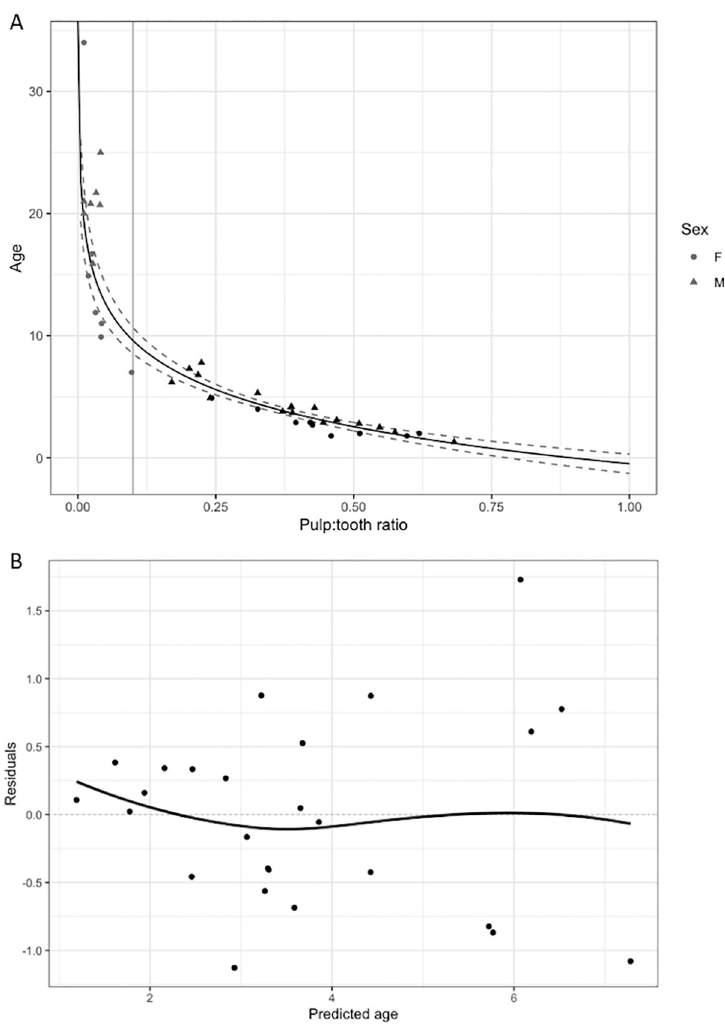
Fig 5. Fit and prediction error of the linear-log regression analysis. (A) Plot of the training dataset used in the linear-log regression analysis to evaluate how well pulp:tooth area ratio can predict age. The points represent individual dolphins with both periapical dental radiographs and life history-based age estimates from SB and BB (n = 40). Due to the low number of samples for pulp:tooth area ratios between 0.04 and 0.17, as well as the wide range of life history-based ages for pulp:tooth area ratios less than 0.04, samples (grey points) with pulp:tooth area ratios < 0.1 (vertical grey line) were excluded. The remaining samples (black points, n = 26) were used to fit a linear- log model of pulp:tooth area ratio against predicted ages (black line, R 2 = 0.85, confidence limits are given as dashed lines). Due to the low sample size, site or sex were not added as covariates, but there did not appear to be obvious differences between males (triangles) and females (circles), nor between the sites, above the 0.1 threshold. (B) Residual errors for the linear-log model including SB and BB dolphins (n = 26). The increasing variation in residuals with increasing age predictions indicates that the model performs better with larger pulp:tooth area ratios (younger